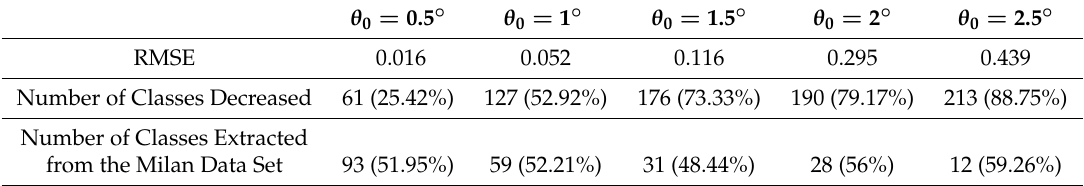
Table 1. Mean RMSE values calculated after comparing the original classification with the reduced set of comportments obtained using different values for ( θ 0